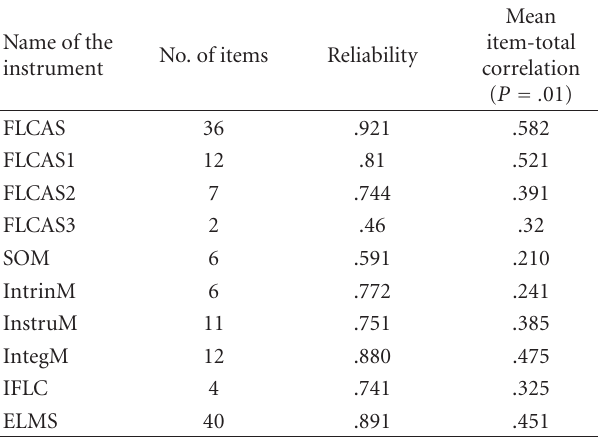
Table 1: Characteristics of instruments ( N =